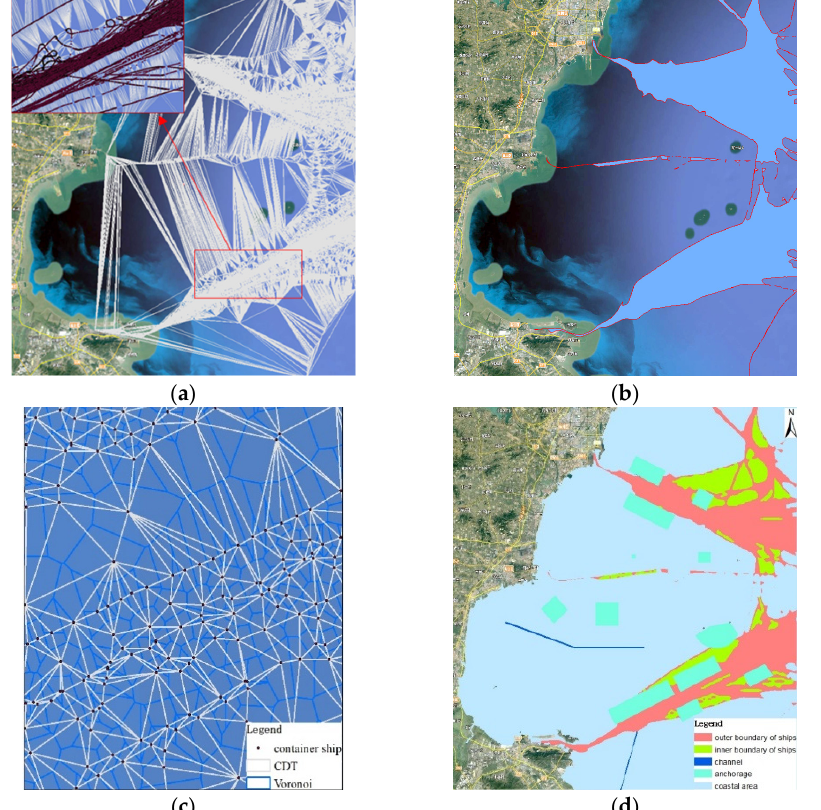
Figure 5. Boundary extraction of ship trajectories. ( a ) CDT triangulation construction; ( b ) outer boundary extraction of ship trajectories; ( c ) Voronoi diagram construction; ( d ) navigable area.